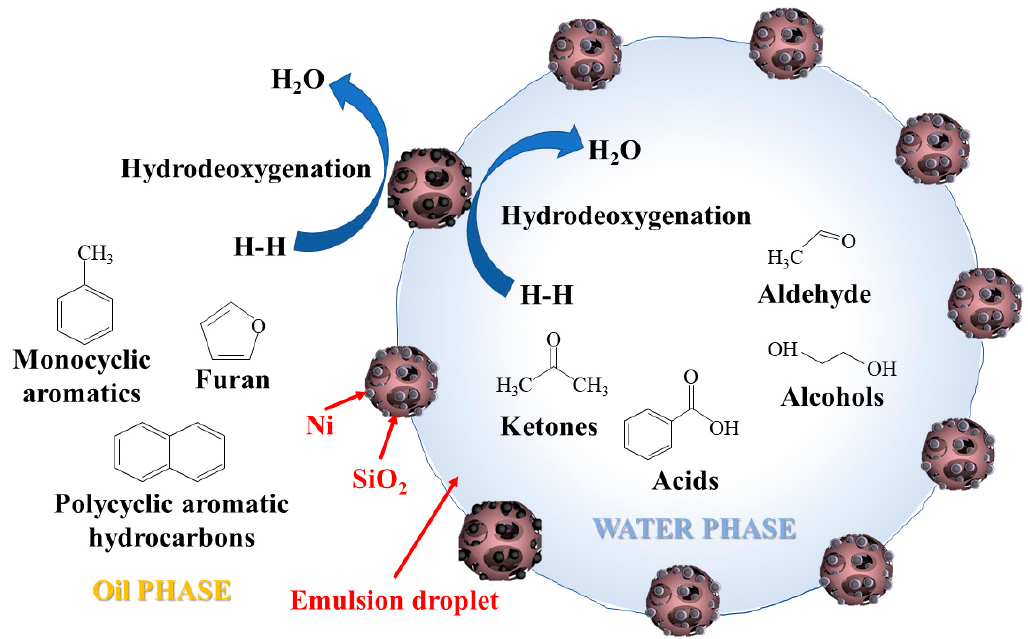
Figure 14. Mechanism of Pickering emulsi fi cation hydrodeoxygenation reaction of bio-oil.